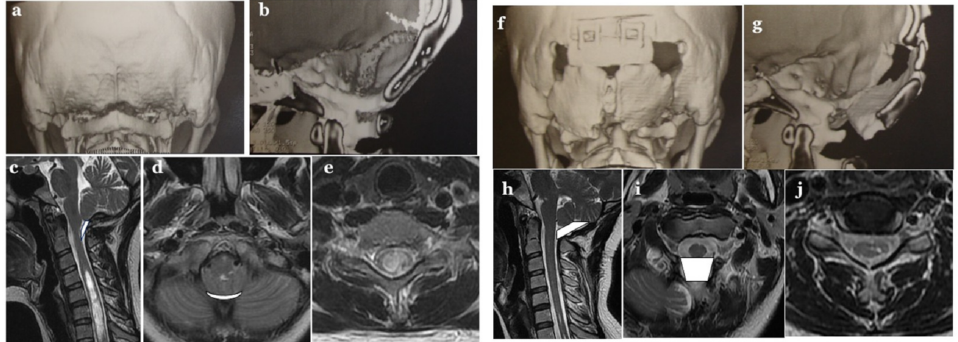
Figure 4. Illustrative cases pre-Op.: ( a – e ), Post-Op.: ( f – j ).